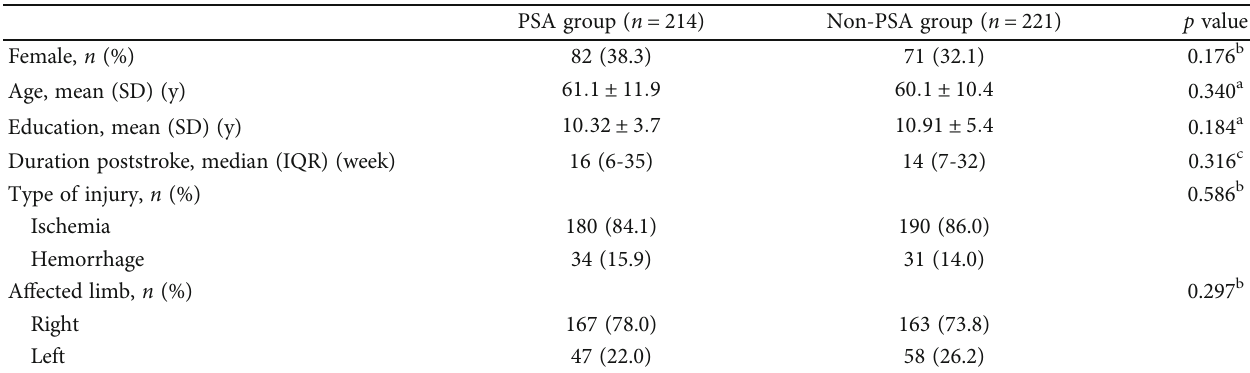
(a) Comparisons of demographic data between the PSA group and the non-PSA